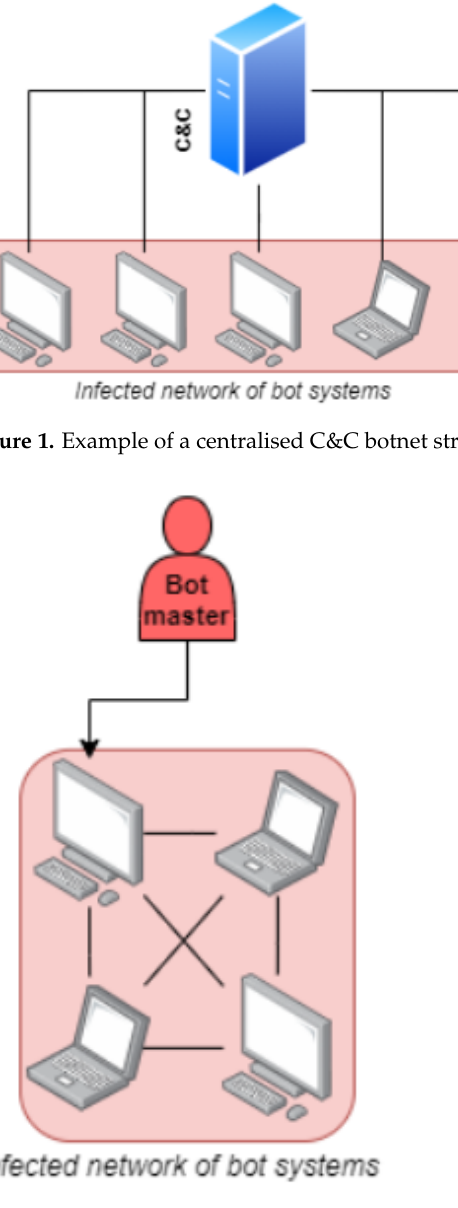
Figure 2. Example of a decentralised (P2P) C&C botnet